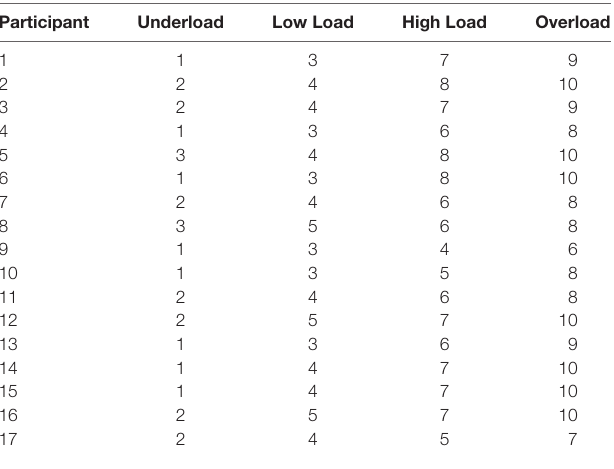
TABLE 3 | Individualized participant WM load levels per